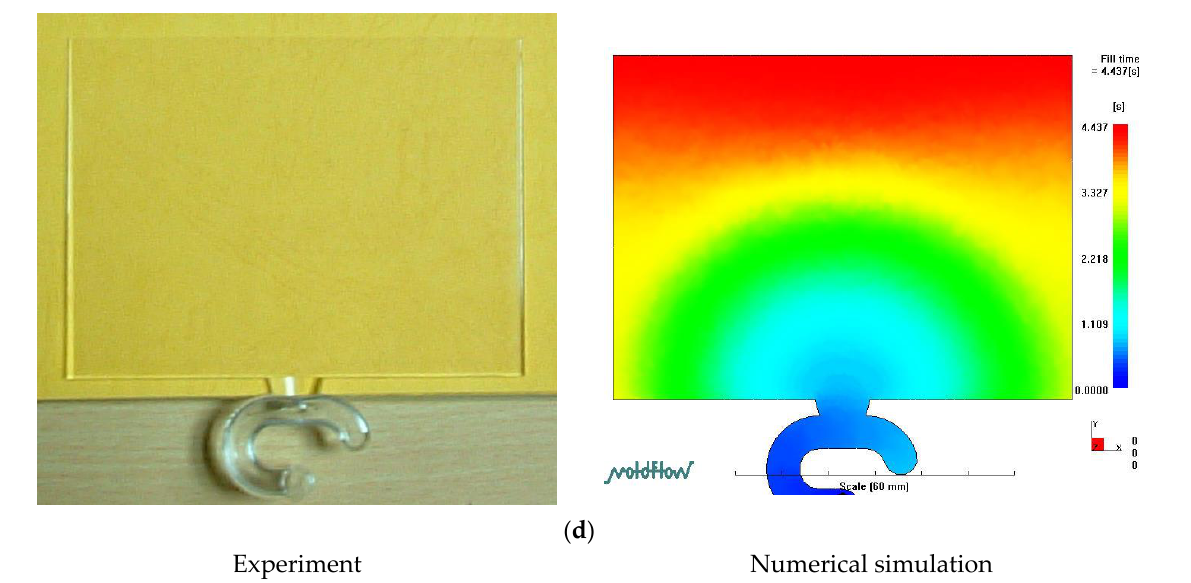
Figure 5. Melt front hysteresis between experiment and 3D numerical simulation. ( a ) Filling phage: 30%, ( b ) filling phage: 60%, ( c ) filling phage: 90%, ( d ) filling phage: 100%.